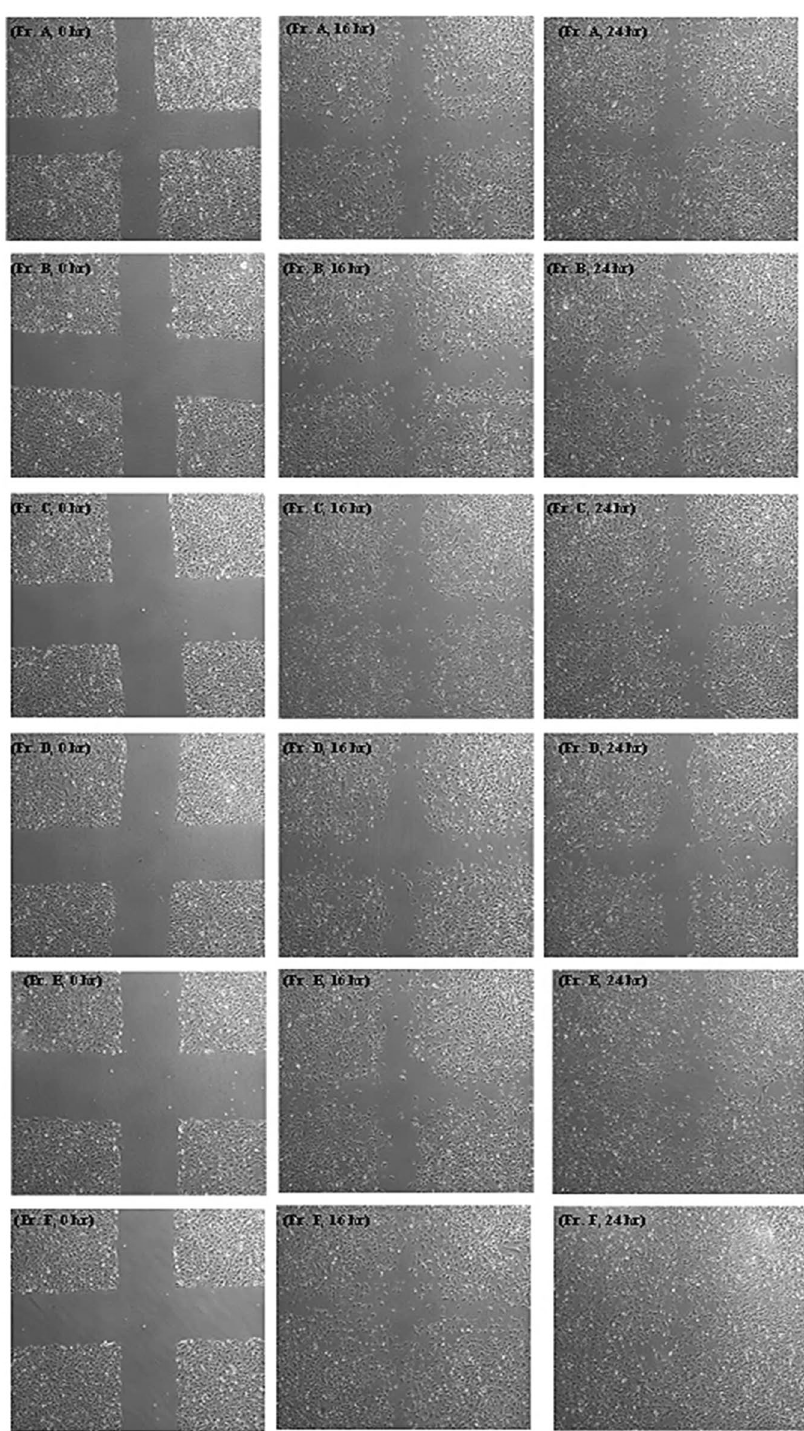
Figure 4. Effect of different fractions obtained from the cyclohexane extract at their maximum non-toxic concentrations on HMEC-1 migration (scratch test). Images from the top to the bottom of the panel: Fr. A, Fr. B, Fr. C, Fr. D, Fr. E and Fr. F respectively. Images were acquired 0, 12, and 24 h after scratching and treatment with the fractions using a fluorescence microscope at 4× magnification. T scratch software was used to analyze the